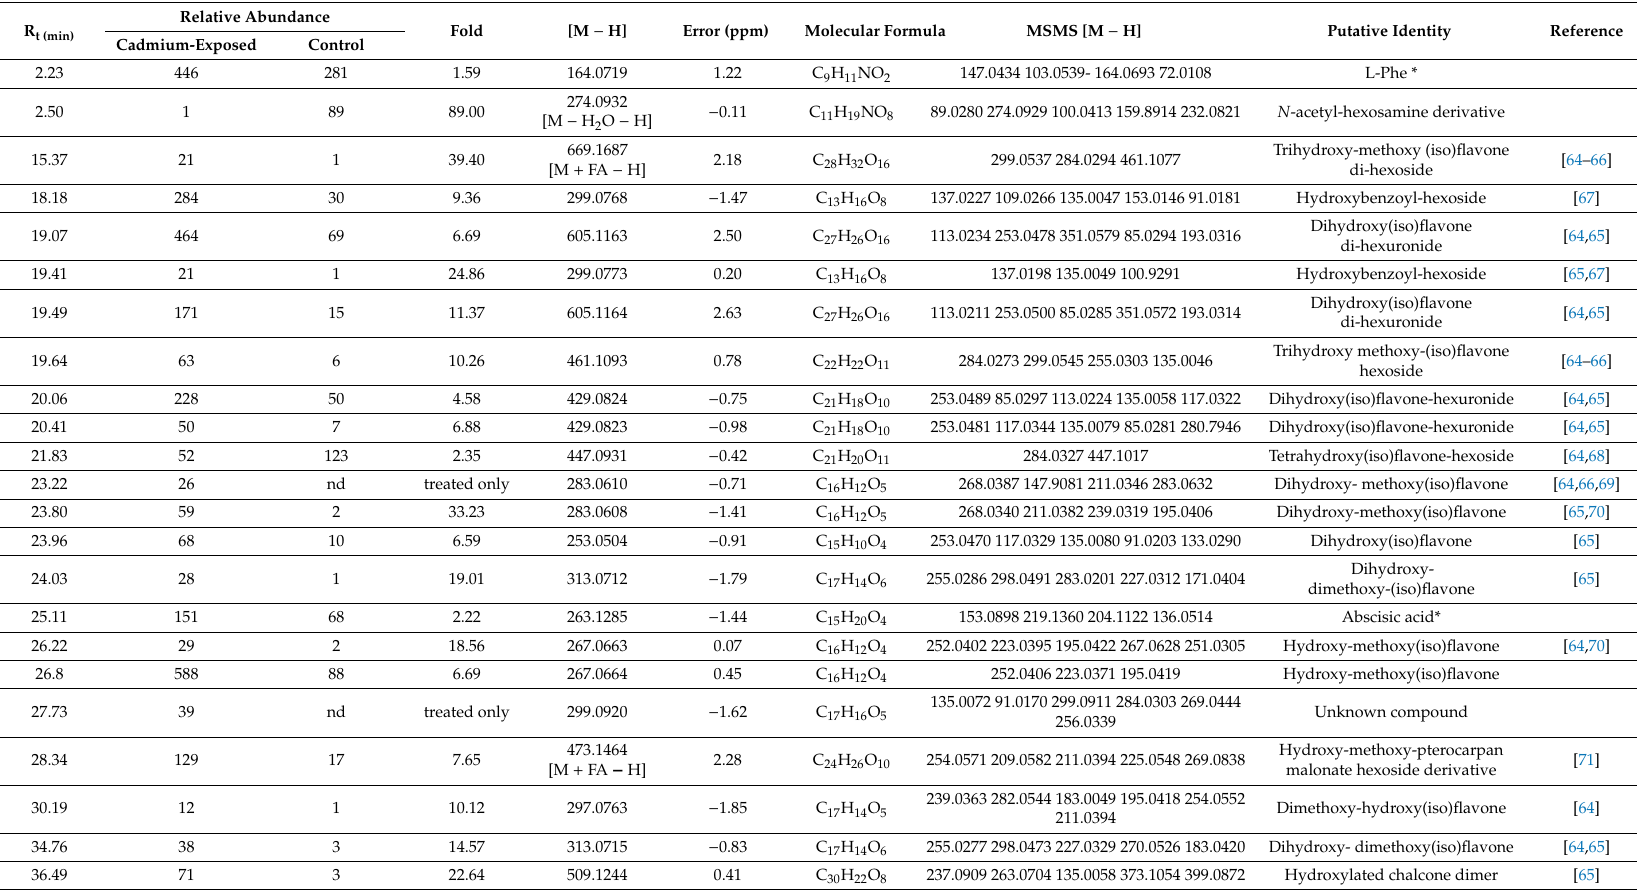
Table 2. List of di ff erentially abundant compounds in M. sativa stems after long-term Cd exposure. Data were obtained by UHPLC–MS in negative mode, with MS / MS experiments. The relative abundance of each peak in stems of control and Cd-exposed plants is based on the selected ion current and is presented as the average normalized value of two technical replicates from five biological replicates. Rt, retention time; nd, not detected. R